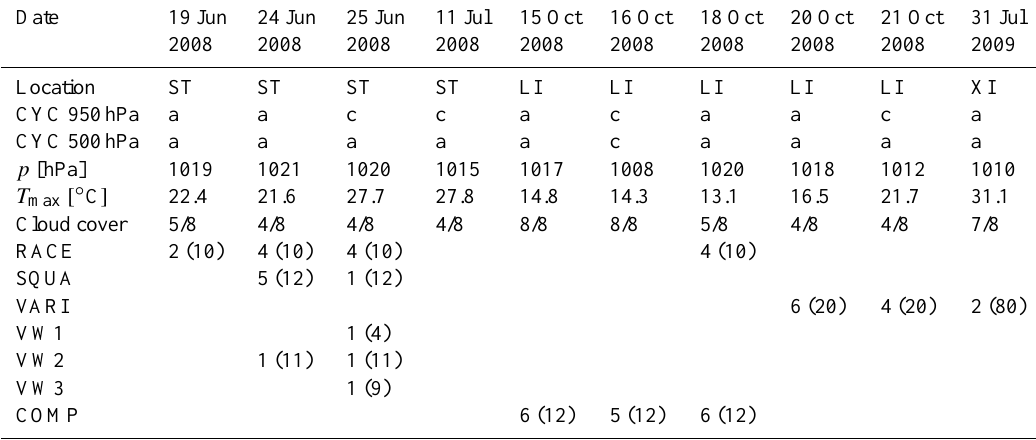
Table 3. Flight campaign summary for locations Lake Starnberg (ST), Lindenberg (LI), and Xilinhot (XI). Anticyclonic and cyclonic conditions are indicated by a and c, respectively. For the flight patterns racetrack (RACE), wind square (SQUA), variance optimization (VARI), vertical wind specific flights (VW1–VW3) and the comparison to ground based measurements (COMP) the number of available datasets for each date is given together with respective track length (km) in parenthesis. Additional information is given in Sect.